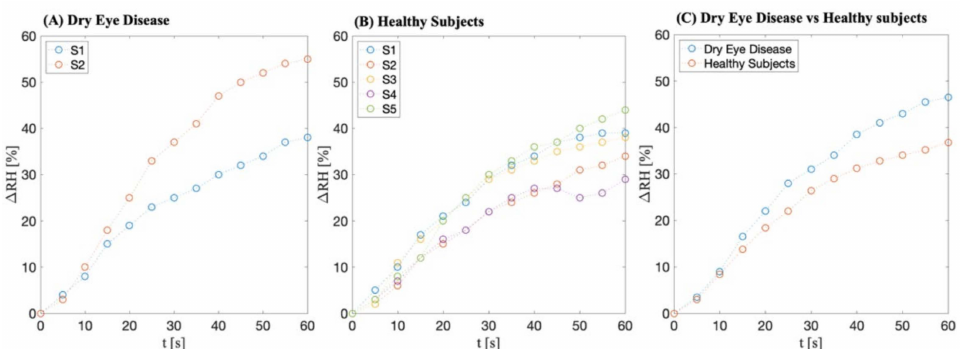
Figure 3. ( A ) The RH increase in time considering the whole trial for patients with dry eye disease; ( B ) the RH increase in time considering the whole trial for healthy subjects; ( C ) the mean values of RH increase in time: patients with dry eye disease vs. healthy